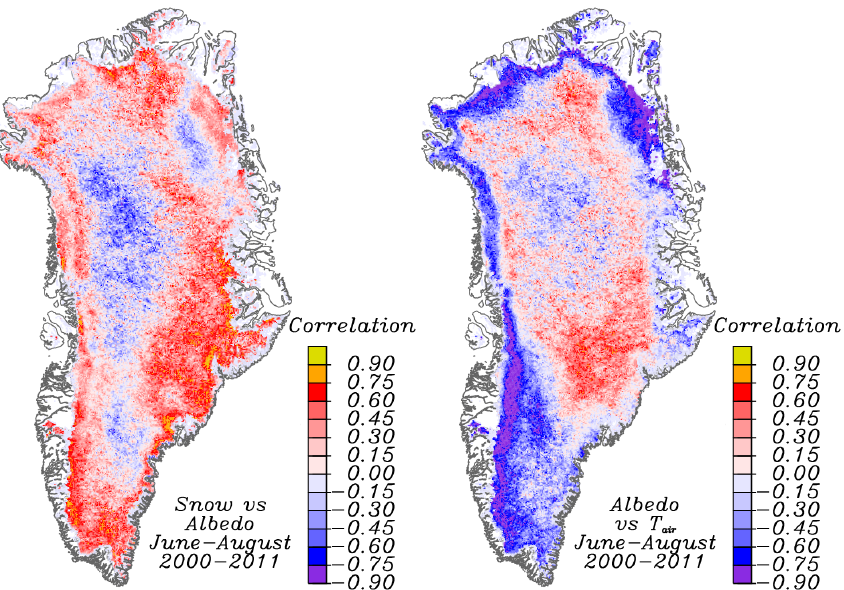
Fig. 11. (a) Summer (June–August) spatial patterns of the correlation between 5km averaged MODIS MOD10A1 albedo and 25km averaged MAR snowfall data. (b) Summer (June–August) spatial patterns of the correlation between 5km averaged MODIS MOD10A1 albedo and 25 km averaged MAR T air